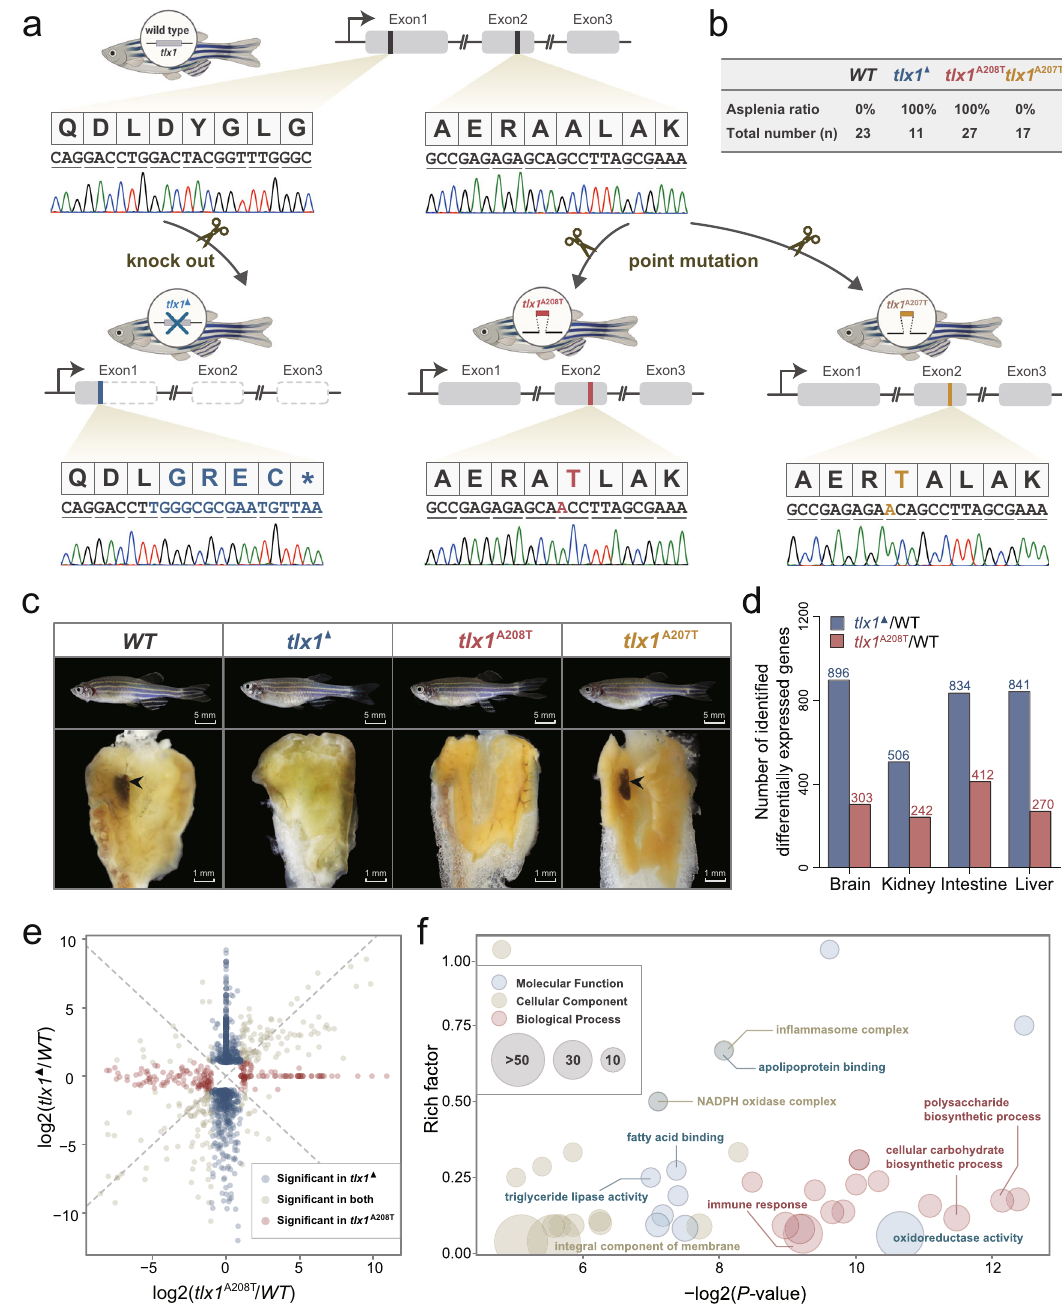
Fig. 3 | Missense mutation of tlx1 controls asplenia phenotype in zebra fi sh. a Genomeeditingofthreezebra fi shlines( tlx1 ▲ , tlx1 A208T and tlx1 A207T )usingCRISPR/ Cas9 technology. Procedures are detailed in Supplementary Fig. 15. ▲ represents full knockout of the gene, while A208T and A207T indicate the speci fi c point mutations atsites622and 619ofzebra fi sh tlx1 ,respectively.Blue, tlx1 ▲ ;Red, tlx1 A208T ;Yellow, tlx1 A207T . The tlx1 nucleotidesequenceofgenomic DNAofthree zebra fi sh lines was validated by Sanger sequencing. The fi gure was created with BioRender.com. b , c tlx1 ▲ and tlx1 A208T zebra fi sh exhibited asplenia while tlx1 A207T zebra fi sh had an intact spleen; the asplenia ratio of individuals was calculated and listed ( n =11~23). The splenic phenotype of other 74 individuals were listed in Supplementary Figs. 16 – 18. WT wild type. d Differentially expressed gene (DEG) number of tlx1 ▲